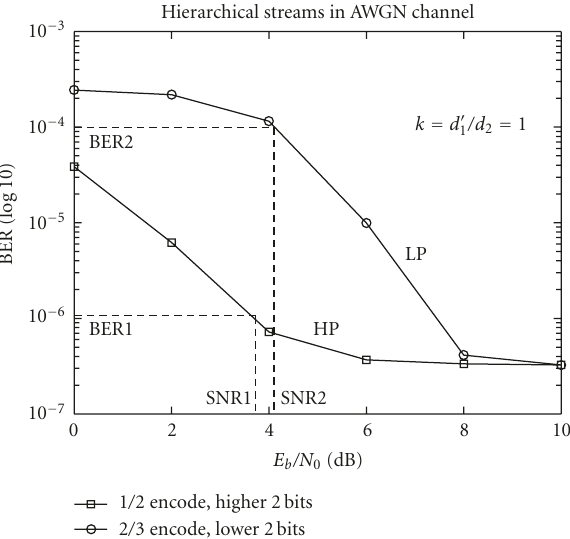
Figure 3: Bit error rate curves for a convolutional coded hierarchi- cal modulation scheme, with a fixed value of k =